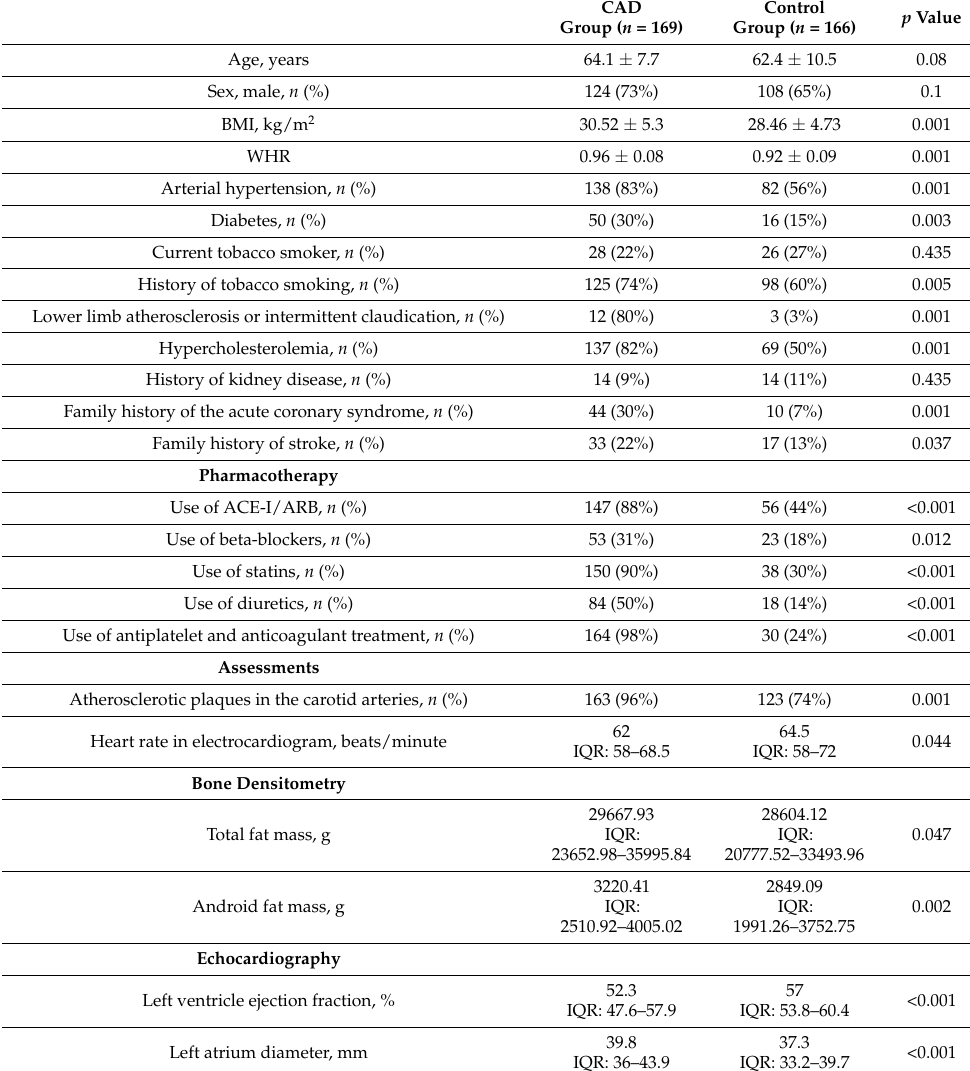
Table 2. Characteristics of study